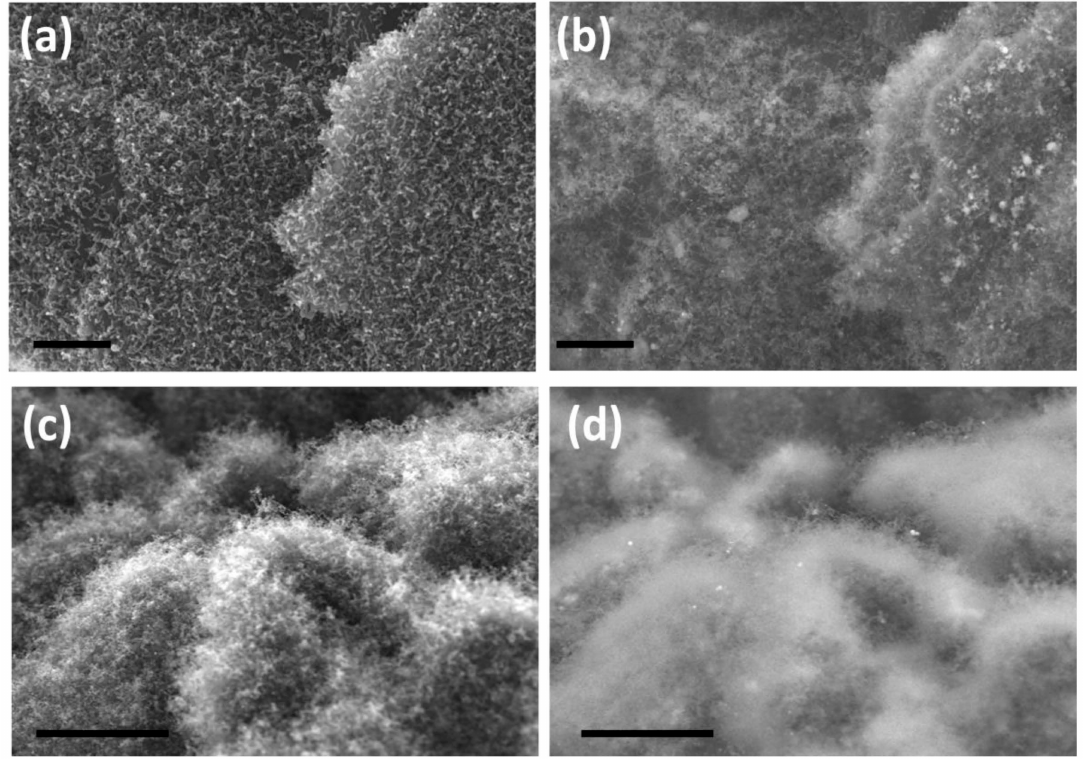
Figure 4. Representative in-lens and their corresponding secondary electron SEM micrographs of H 3 BTC derived carbon nanotubes using cobalt ( a , b ) and iron catalysts ( c , d ). Scale bar is 1 µm in ( a , b ) and 3 µm ( c , d ).